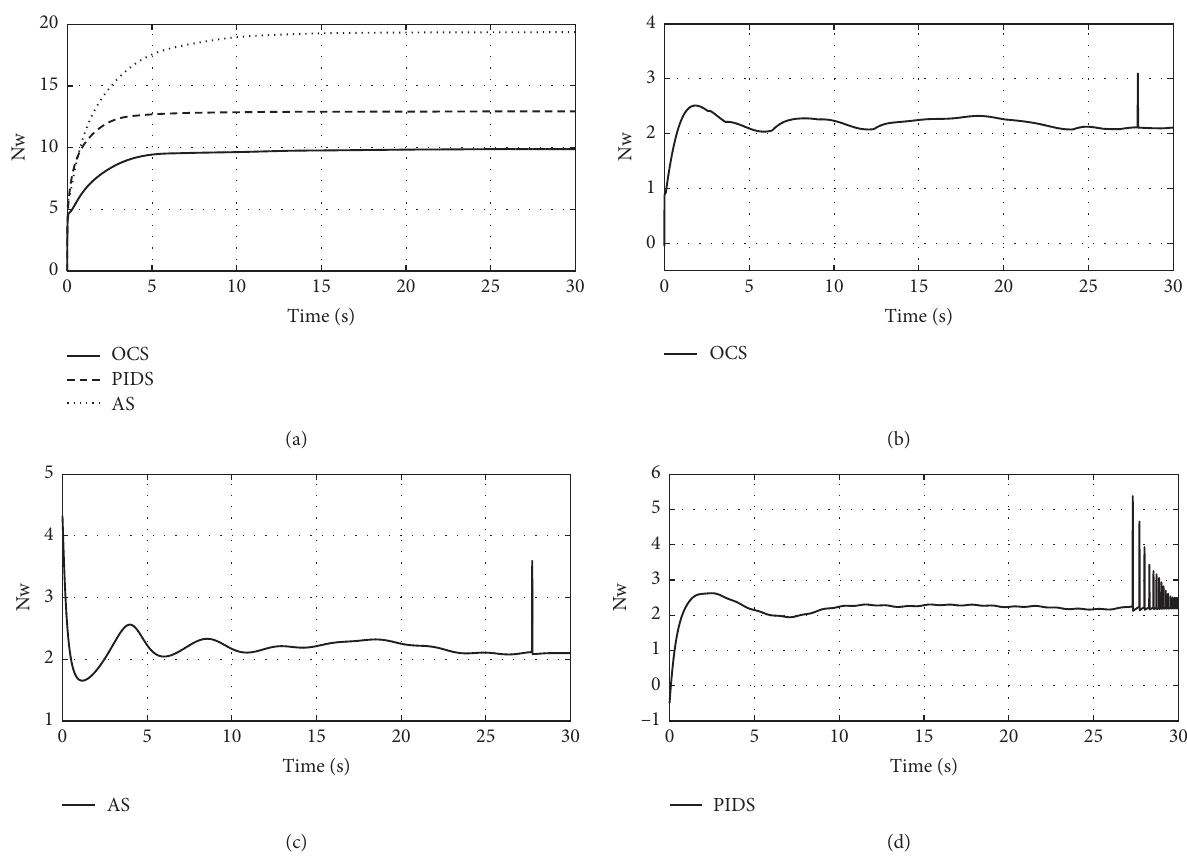
Figure 3: Comparison among the control strategies OCS, PID, and AS, when the system is perturbed by a normally distributed random process with zero